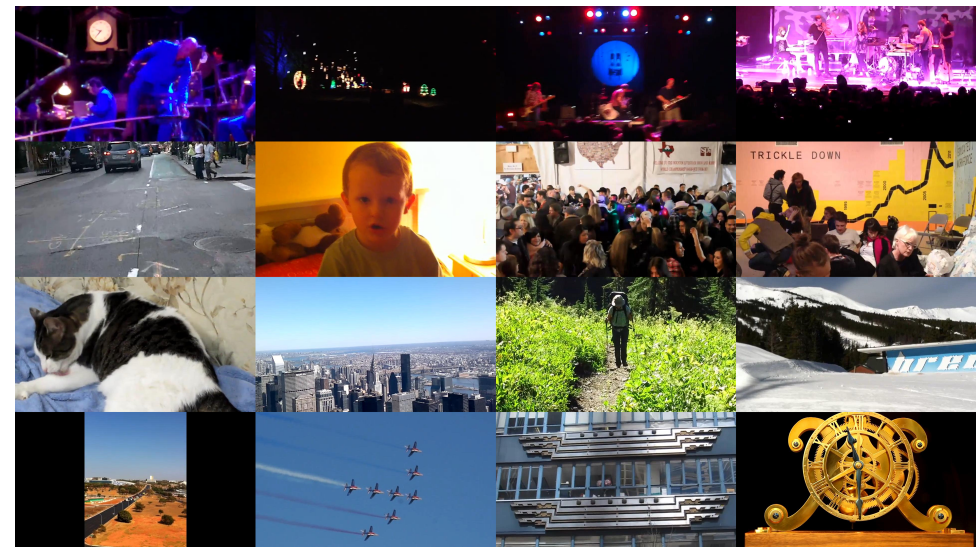
Figure 6. Illustration of several videos from KoNViD-1k [7] VQA benchmark database.